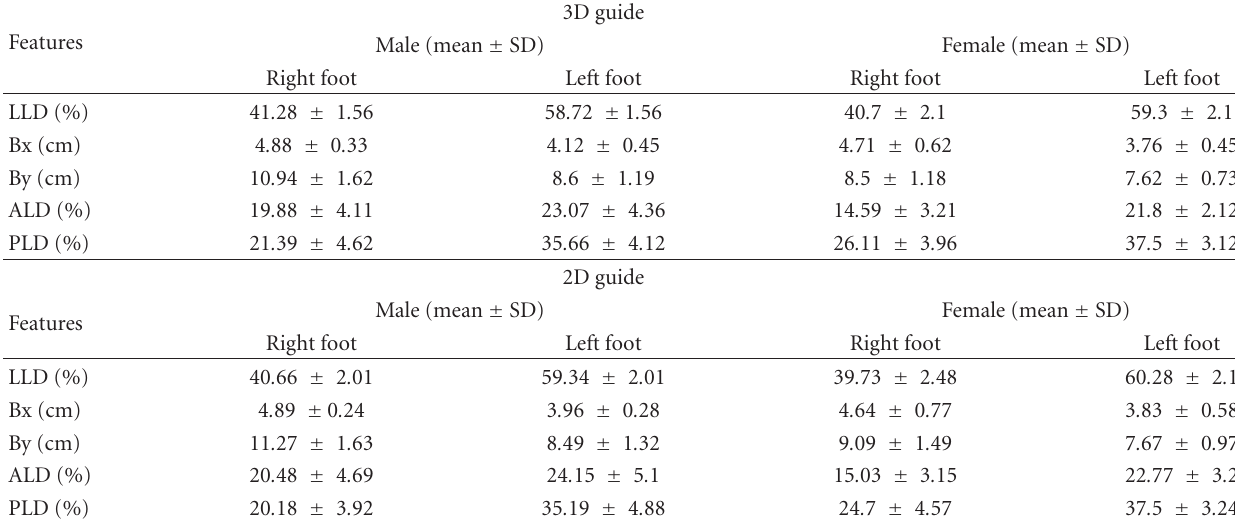
Table 7: 3D guide and 2D guide results—female and male